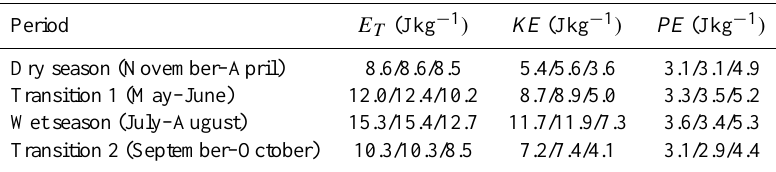
Table 2. Seasonal total, kinetic, potential GW energy densities in the Lower Stratosphere at heights between 19 and 23km during the dry, monsoon, Transition 1 and Transition 2 periods. The first values refer to Niamey at 00:00UT, the second ones to Niamey at 12:00UT and the third ones to Ouagadougou 12:00UT.